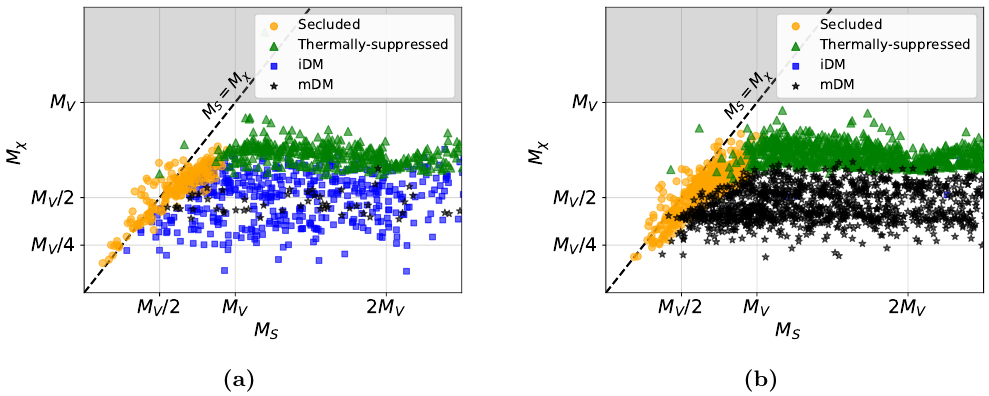
Figure 2. Data points satisfying BBN bounds and the relic density constraint from the numerical scan described in the main text, represented in the ( M S ; for (a) (cid:1) (cid:31) < 0 : 5 M (cid:31) and (b) (cid:1) (cid:31) > 0 : 5 M (cid:31) . We have classi(cid:12)ed them in four regimes: inelastic DM (blue squares), Majorana DM (black stars), secluded regime (orange circles), and forbidden regime (green